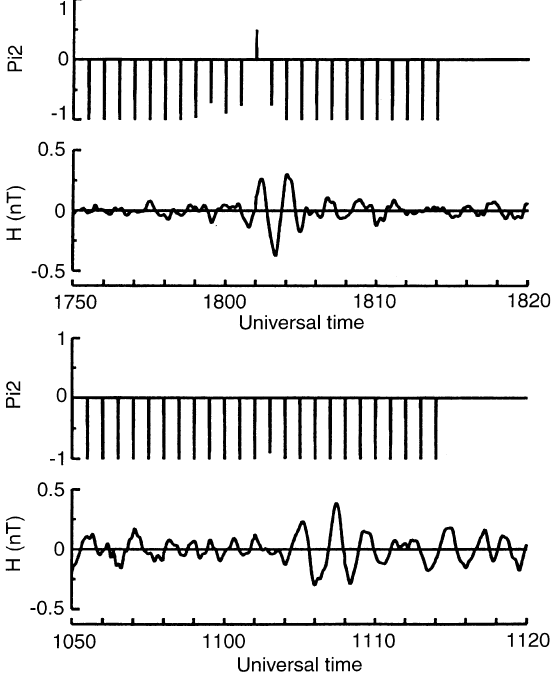
which were visually discernible. In the lower example there is no evidence of the Pi2 in the ANN output. In the upper example there is evidence of the Pi2 in the ANN output, but it failed the selection criteria